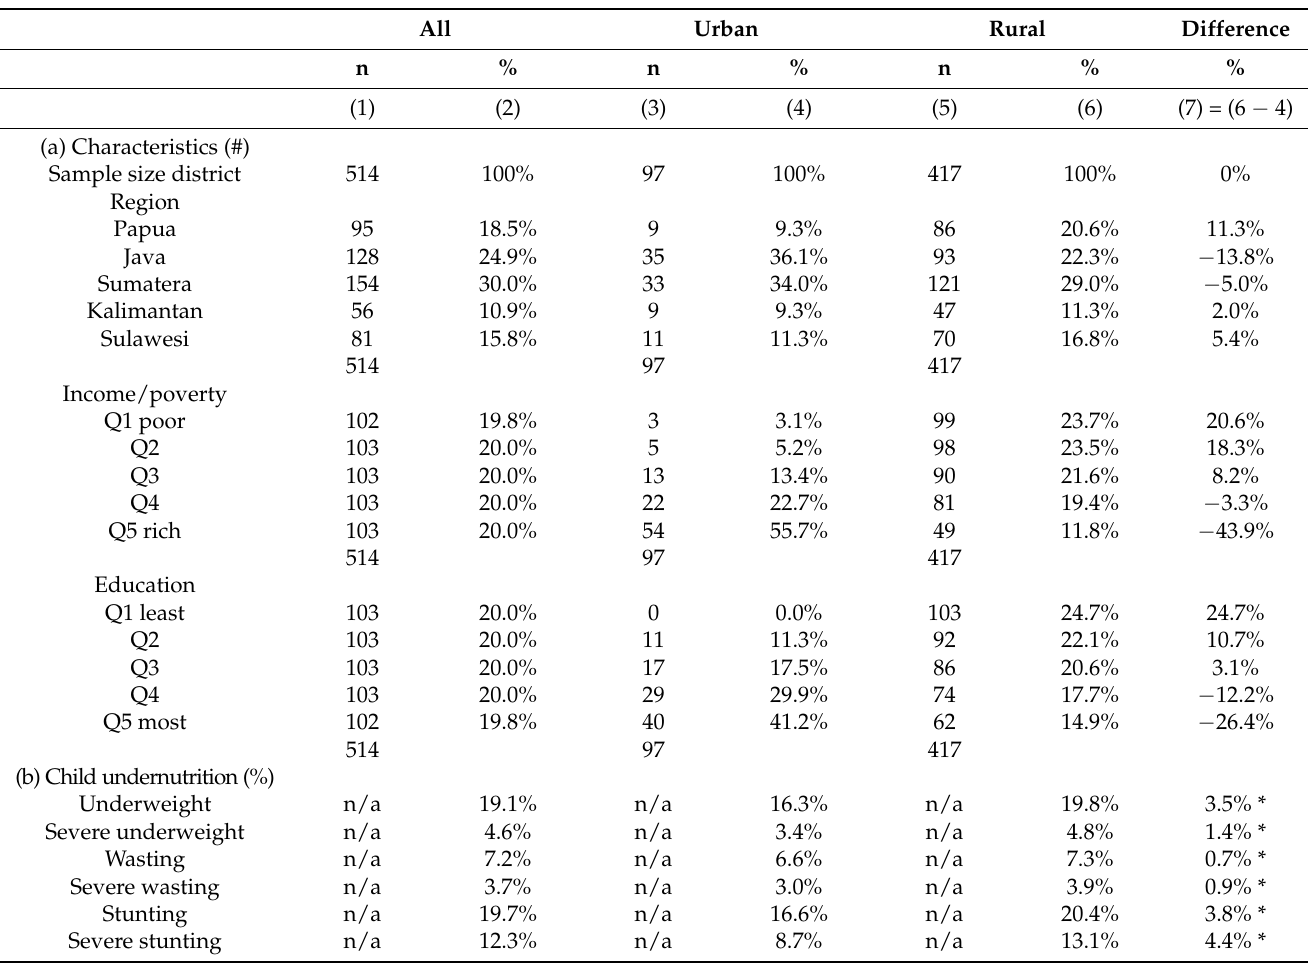
Table 2. Characteristics of districts and child